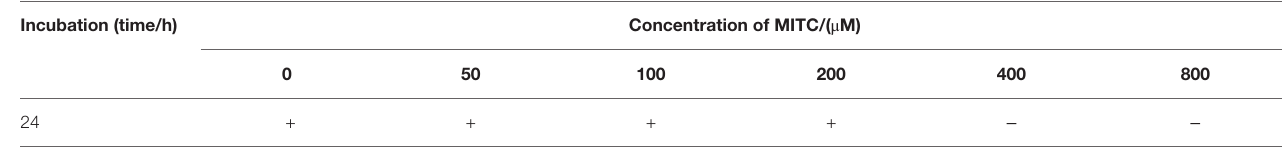
TABLE 2 | Effects of different concentrations of moringin on Listeria monocytogenes .